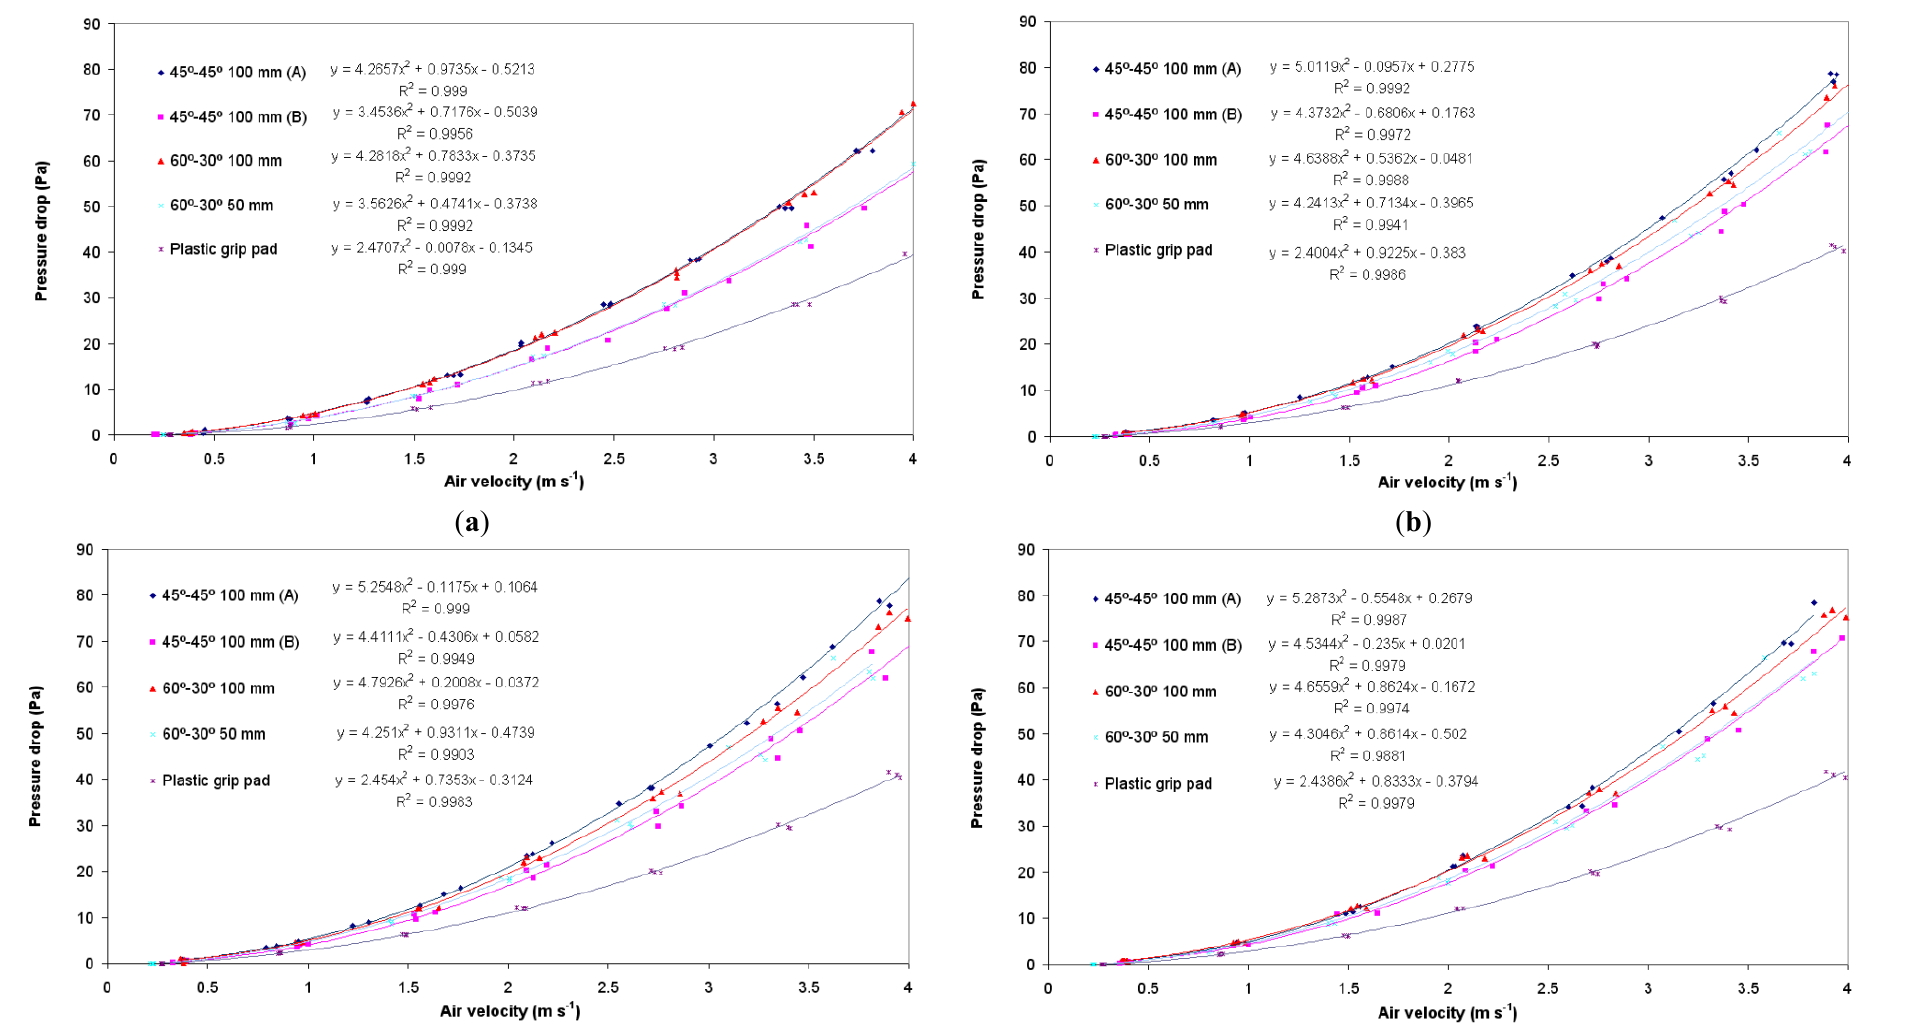
Figure 6. Comparison of pressure drop between the cellulose pads and the plastic grid block at different air velocities and for the